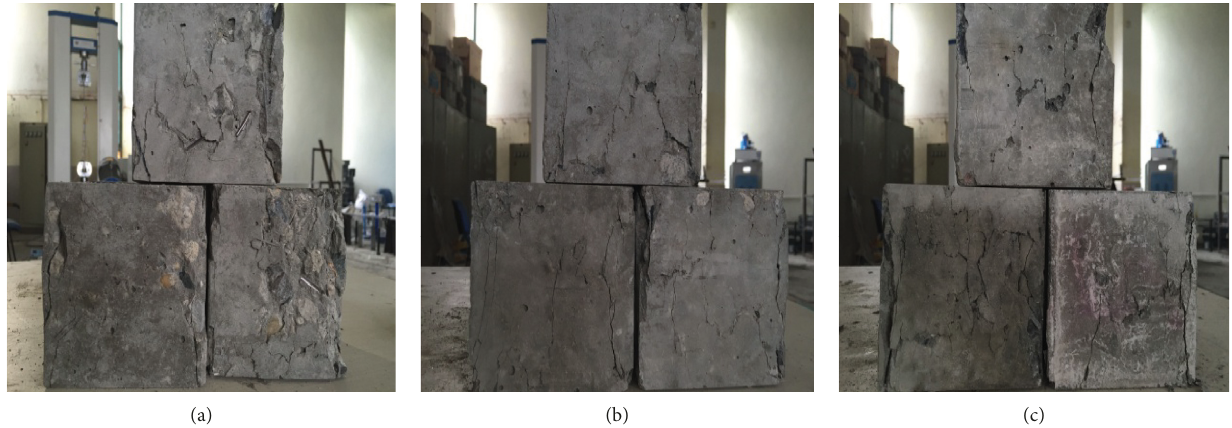
Figure 4: Failure patterns of cubic specimens of randomly distributed SFRC under compression. (a) 0.4%; (b) 0.8%; (c) 1.5%.